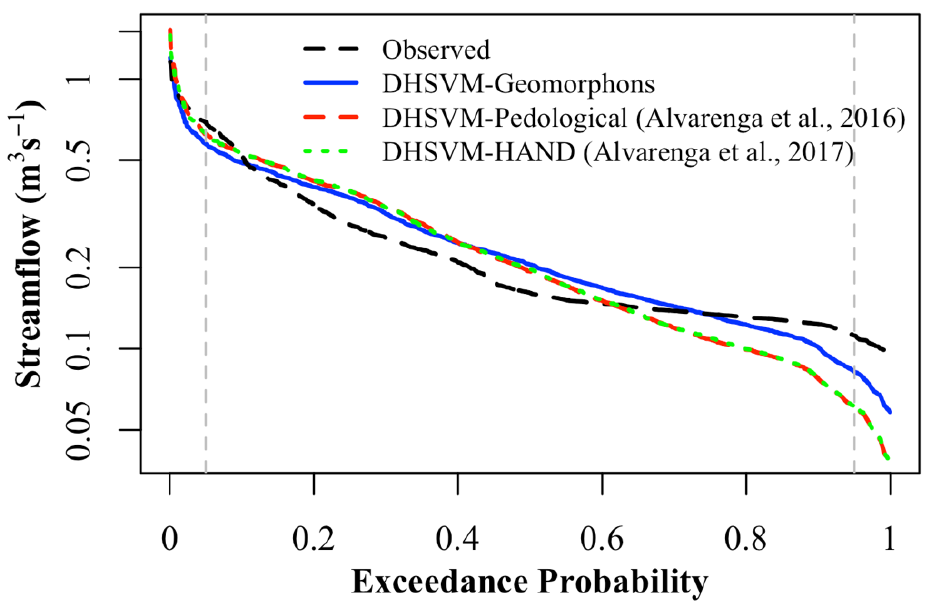
Figure 8. Flow duration curve simulated and observed in the LCW (October 2006 to September 2010).